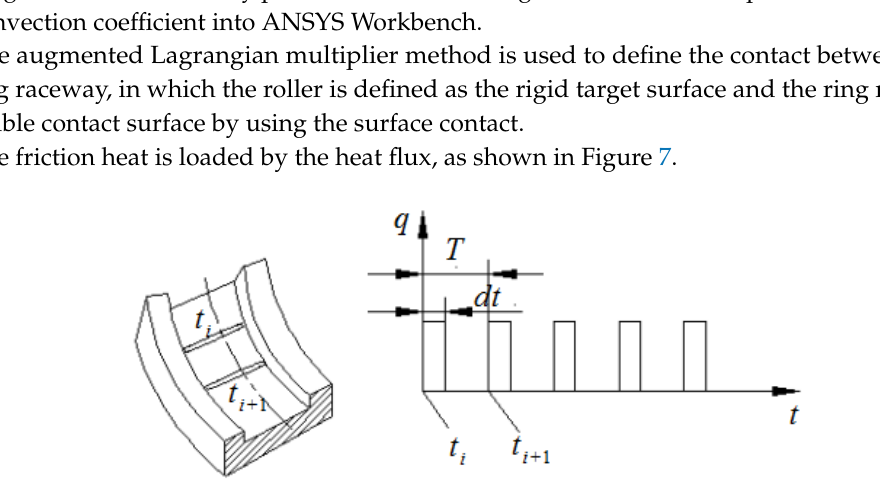
Figure 7. The heat flux and action time of contact surface between the roller and ring raceway.